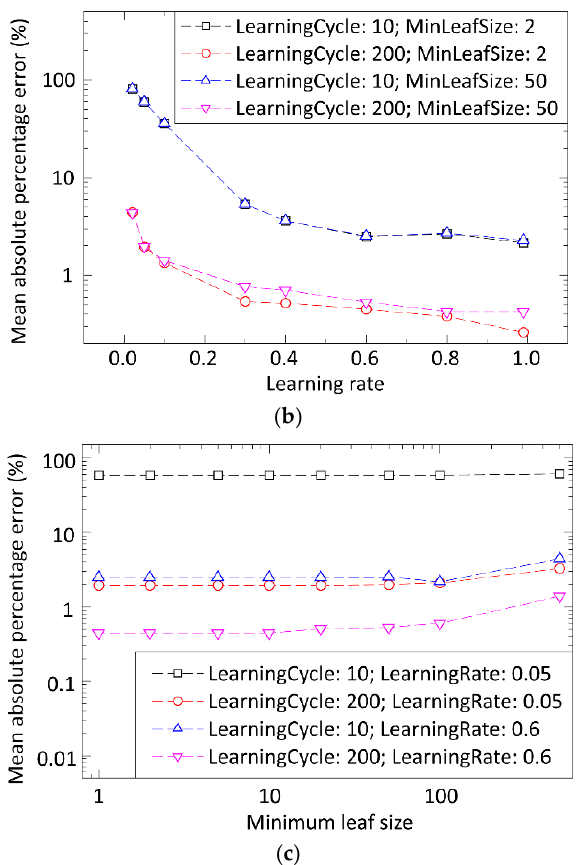
Figure 7. Prediction error of deposited solder paste volume based on the different parameter settings as a function of the: ( a ) number of learning iterations; ( b ) learning rate; ( c ) minimum leaf size.